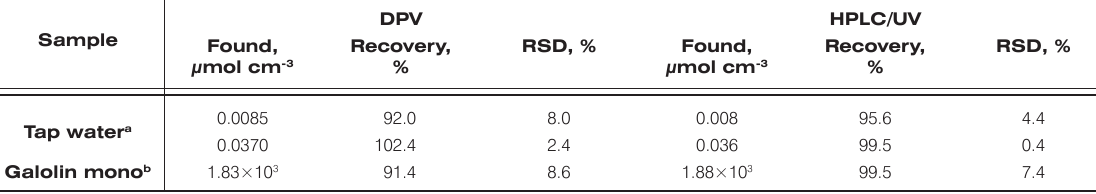
Table 3. Linuron recovery from water samples at GCB electrode using DP voltammetry and HPLC. Sample